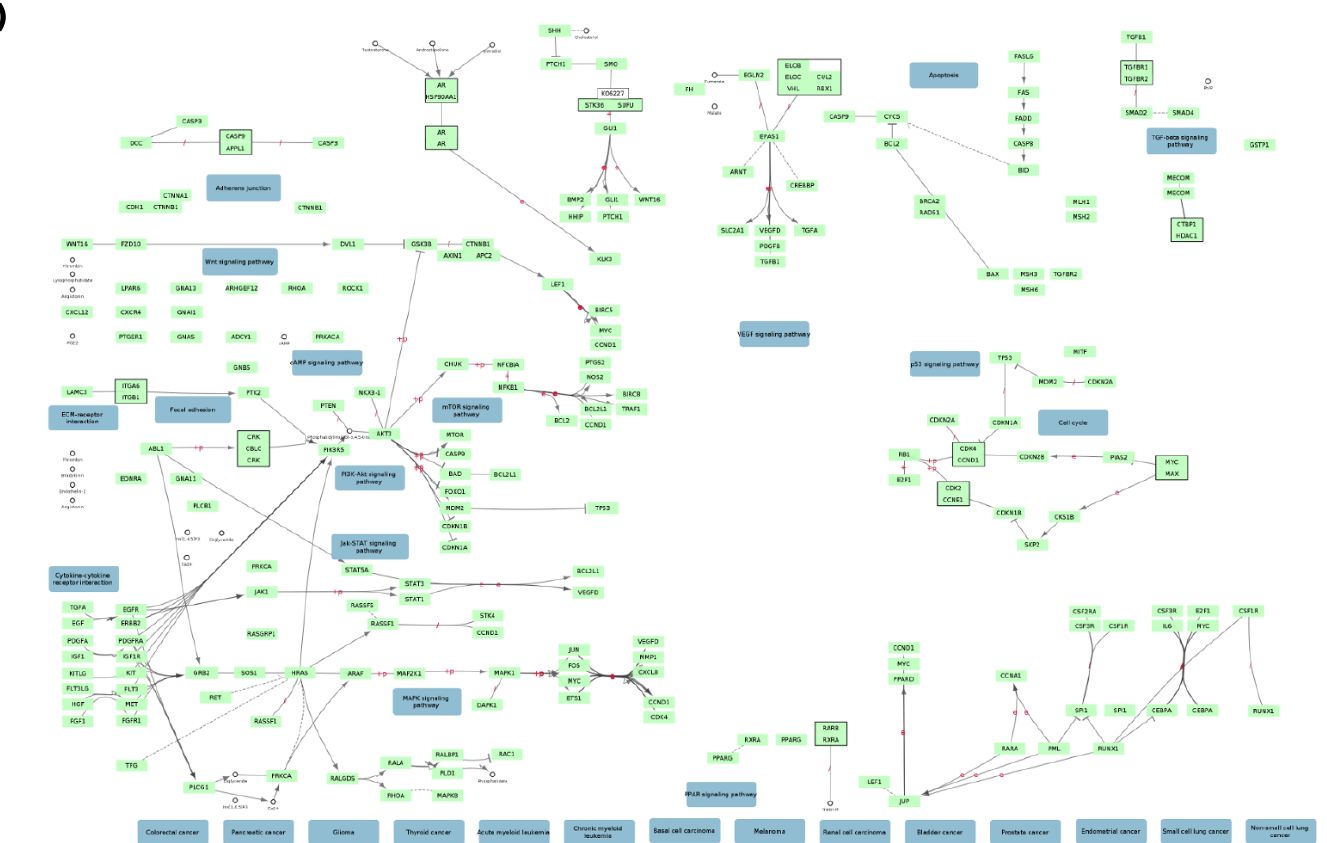
Figure 1. CK2-centered functional association network represented with the database STRING v10.0. ( A ) The network shows the top 50 human genes related to CK2 subunits CSNK2A1, CSNK2A2, and CSNK2B (number of nodes and edges: 53 and 369, respectively) based on neighborhood, experiments, text mining, and database sources. Briefly, the human CK2 subunits were searched in STRING by gene name using the multiple protein search functionality. The functional association network was then retrieved by selecting 50 as the maximum number of interactors to show from the first shell (step 1) and checking the mentioned interaction sources (these options are found within the “data settings” drop down menu); ( B ) A clone of network A with the red nodes representing proteins connected to deregulated pathways (KEGG pathway: hsa05200); ( C ) A network representation of the map: Pathways in cancer (KEGG pathway: hsa05200). The map was downloaded from the KEGG PATHWAY [63] database (accessed 30 November 2016) and imported to Cytoscape with the CyKEGGParser v1.2.7 plugin [64]. A high-resolution image of this figure is also available in the Supplementary Materials.